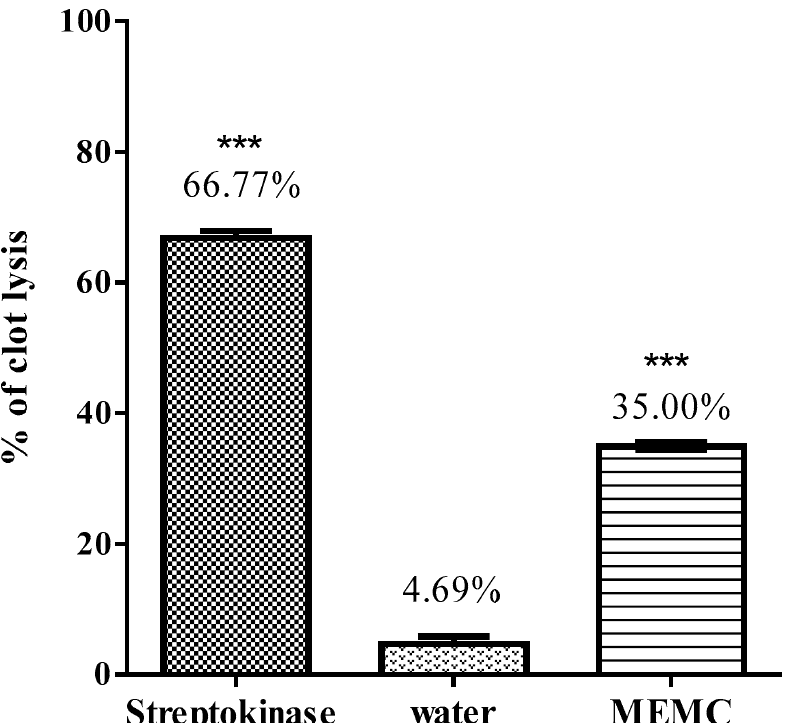
Figure 2. Determination of LC50 value of MEMC and VS (vincristine sulfate) from linear correlation between concentrations versus percentage of mortality. Values are expressed as mean ± SEM ( n = 3) where data were analyzed by two-way ANOVA (Sidak’s multiple comparison test) and *** p value less than 0.001 is considered as statistically significant. MEMC, methanol leaf extract of Molineria capitulata.